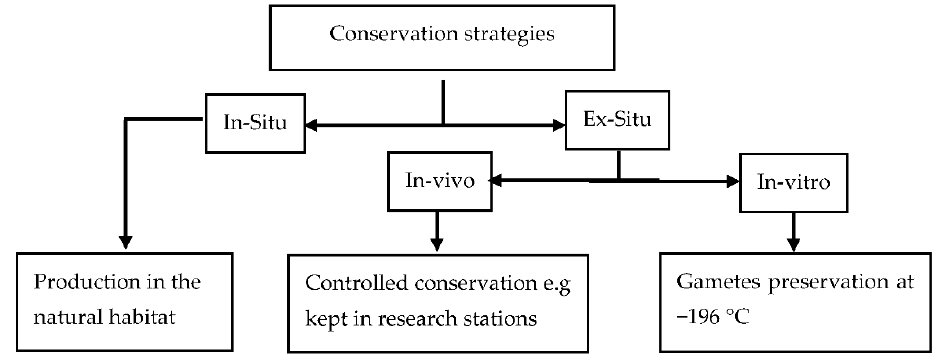
Figure 2. Different methods of livestock conservation [40]. In our view, in situ conservation of South African indigenous breeds is a challenge due to the lack of understanding of the importance of conservation in the rural farmers that was reported by Mavule et al. [2]. Therefore, ex situ conservation (in vivo and in vitro) has been a vital method to conserve these breeds (Tables 5 and 6). For instance, Zulu and BaPedi sheep are kept at the Agricultural Research Council (controlled environment) for in vivo conservation. Mara research station also kept some population of BaPedi sheep [21].